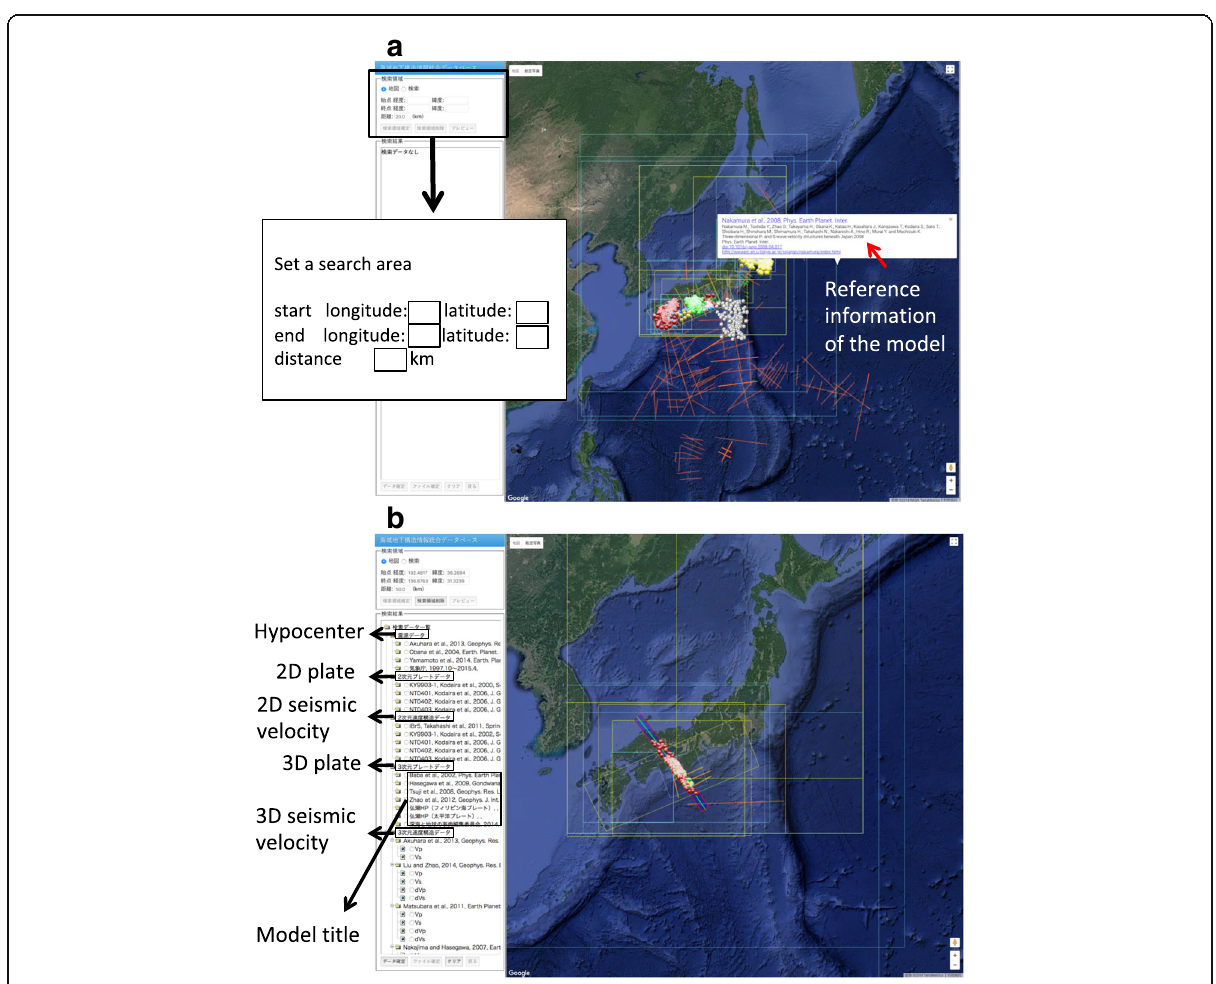
Fig. 4 Web GUI for searching the database. a The first page of the search tool. Green and red lines show the positions of 2D plate geometry and seismic velocity models, respectively. Yellow and green boxes show the extents of 3D plate geometry and seismic velocity models, respectively. Spheres represent hypocenters; hypocenters from the same model are shown in the same color. b The second page of the search tool. After search area selection, the map is refreshed to show only the models containing data within the search area. The left panel lists the titles of the selected models. The green line and red rectangle indicate the search area defined by the user in the first step ( a